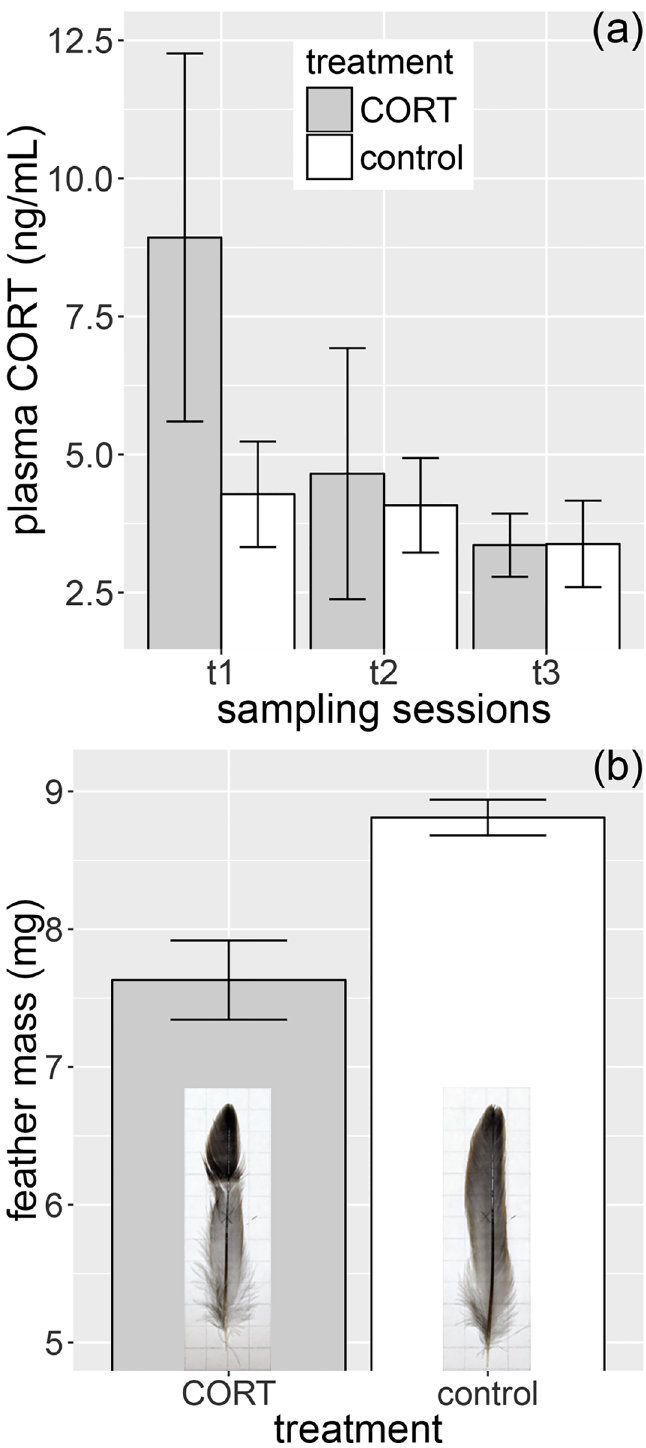
Fig 1. Treatment effectiveness. The effects of CORT-implantation on (a) plasma CORT levels during the first, second and third post-treatment sampling sessions ( t 1 , t 2 and t 3 , respectively) and (b) feather mass of replacement middle rectrices in post-molting house sparrows (feather insets are representative for the two treatment groups). Mean ± 1 SE are shown throughout. Sample sizes for CORT levels are 11 at t 1 , 13 at t 2 and 12 at t 3 .